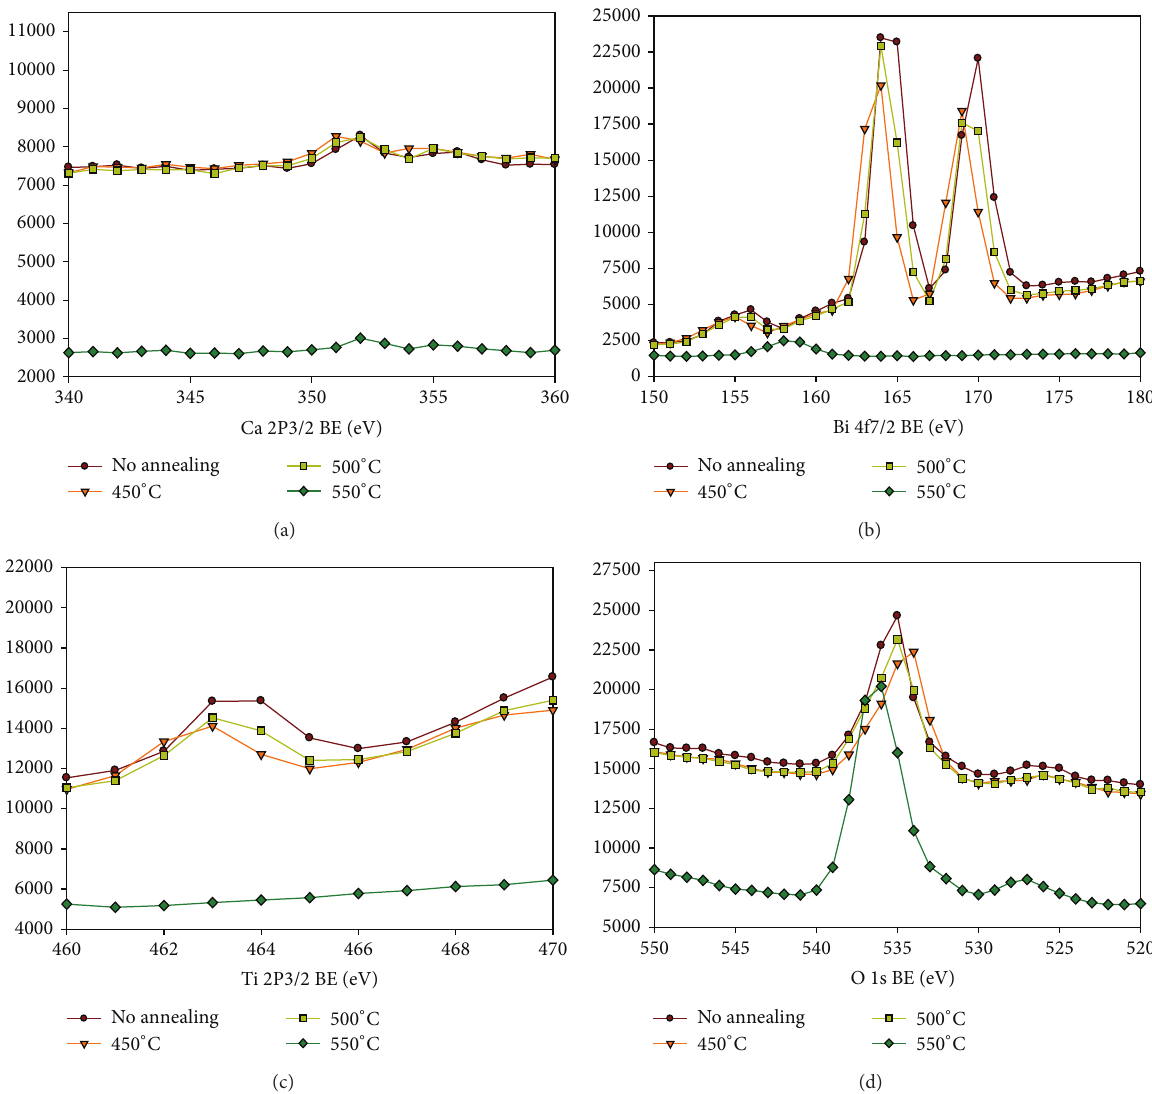
Figure 4: XPS of the CBTi144 thin films with different annealing temperatures: (a) Ca 2p3/2, (b) Bi 4f7/2, (c) Ti 2p3/2, and (d) O